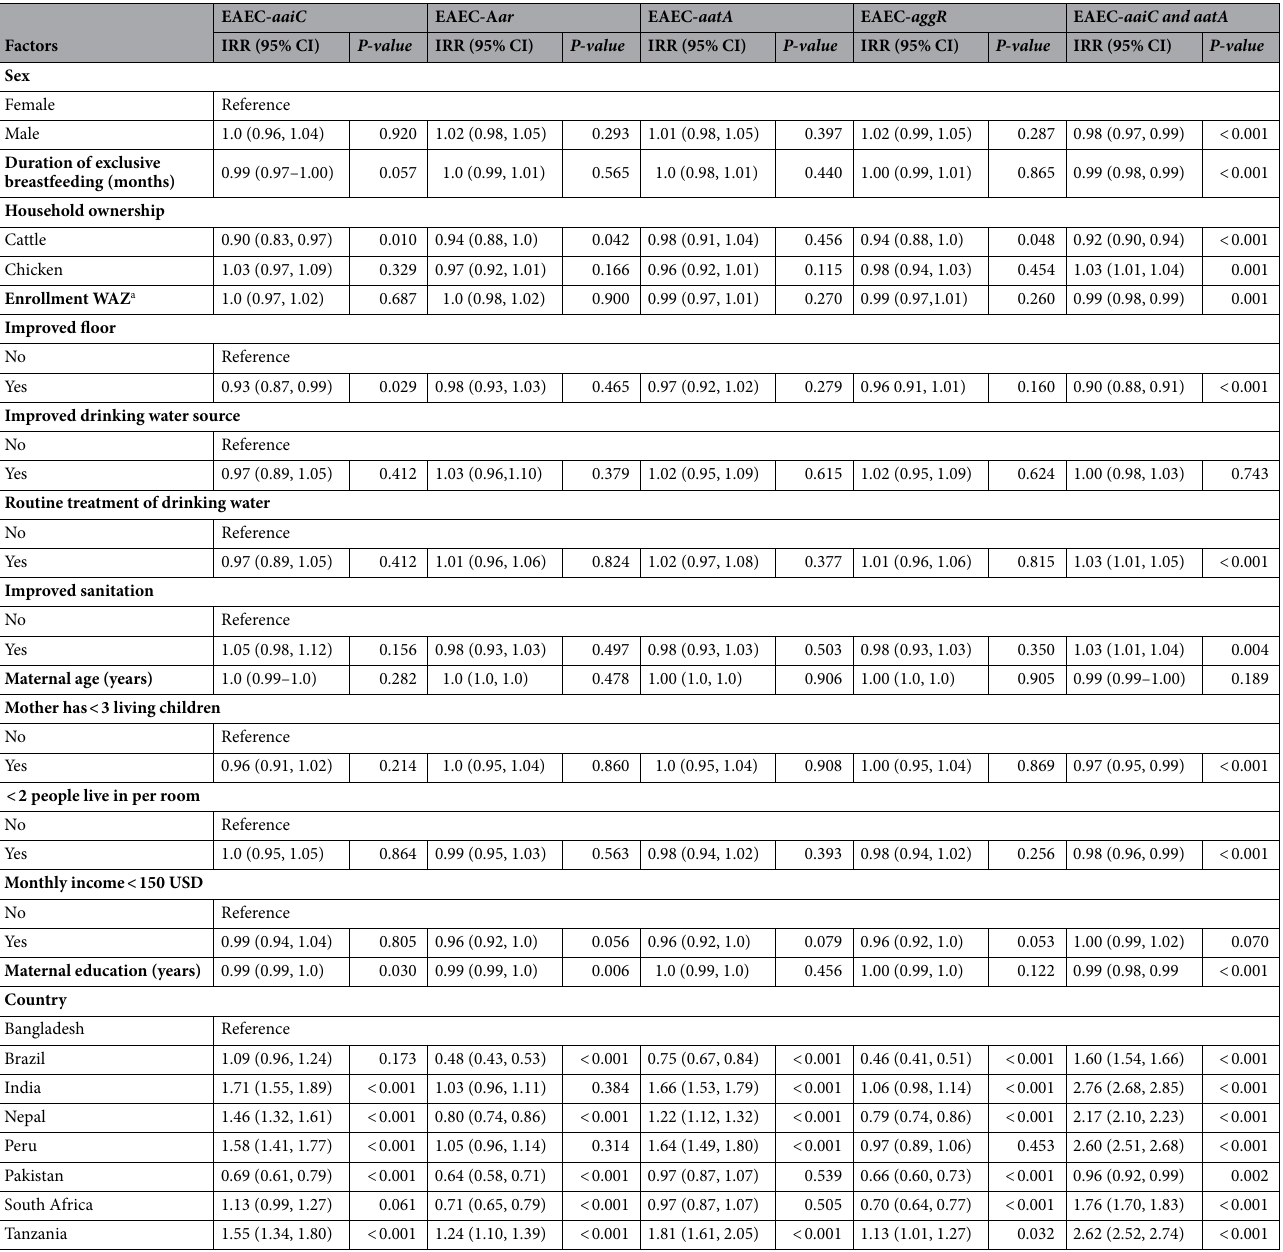
Weight-for-age z score. Dependent variable: Number of infections during follow up (1–24 m); Offset: Log of the total number of follow up; alpha (α): dispersion parameter; Adjusted for the site and all variables included in the multivariable